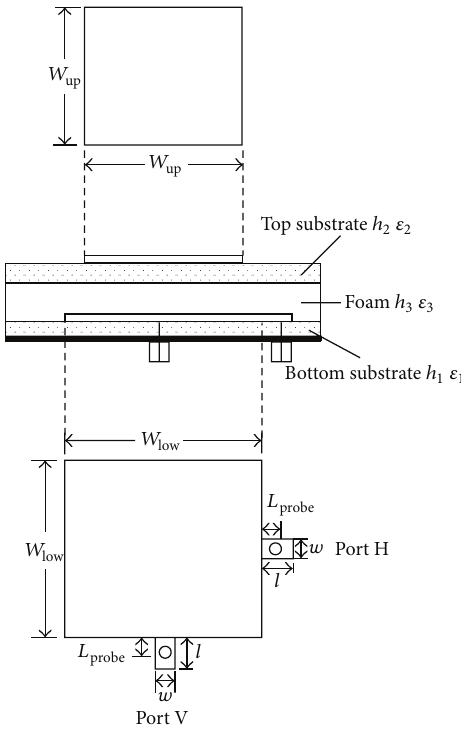
Figure 1: Configuration of the antenna element fed by two orthogonal